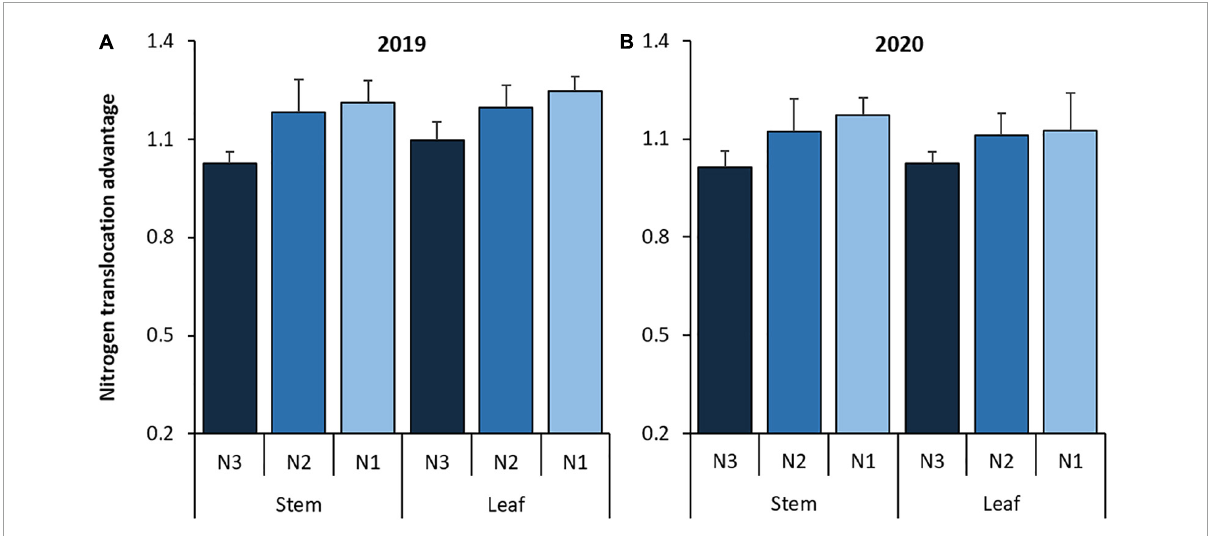
FIGURE4 Nitrogen translocation advantage (NTA) of stem and leaf with NT relative to CT during the wheat growing season in (A) 2019 and (B) 2020. CT and NT represent conventional tillage without plastic film mulching and no-till with previous plastic film mulching. N1, N2, and N3 represent N fertilizer applied at 135, 180, and 225 kg N ha - 1 , respectively. The smaller bars are standard error of means ( n = 3).